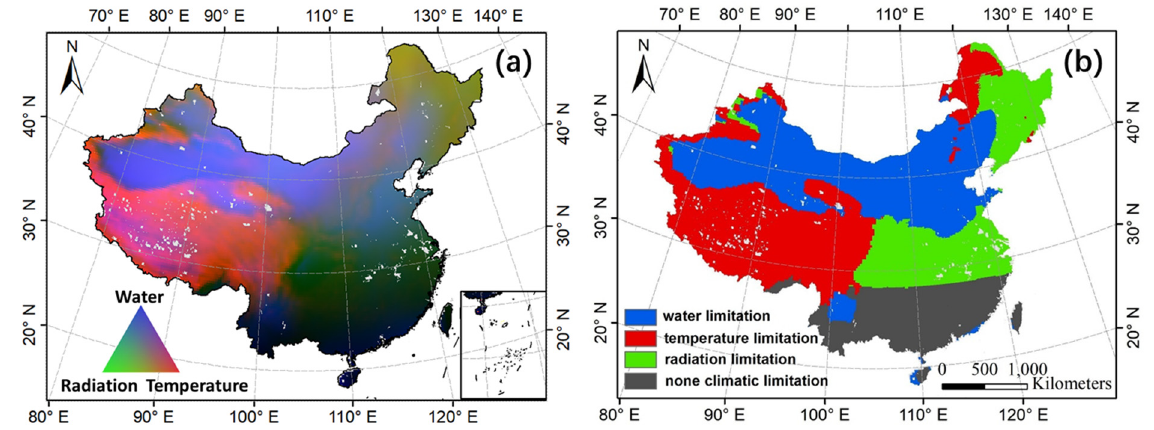
Figure 1. Spatial pattern of climatic limitations in China ( a ) and dominant climatic limitations ( b ).